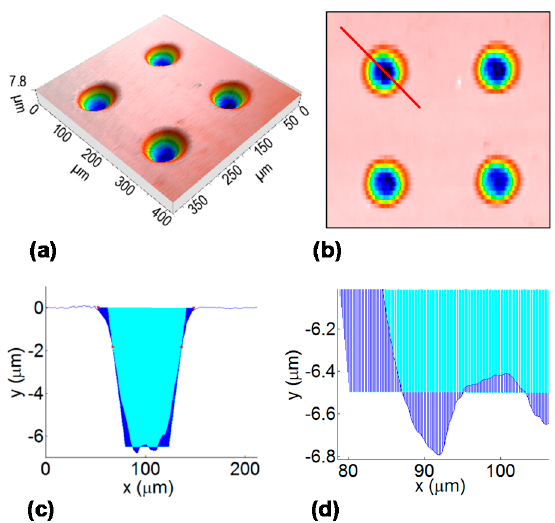
Figure 4. Sketch of the methodology for the determination of the dimple depth profile: ( a ) measured 3D profile, ( b ) top view of the 3D profile with a diagonal line, ( c ) measured linear depth profile in the diagonal compared with the goal profile (blue area represents deviation), ( d ) detail of the bottom part.